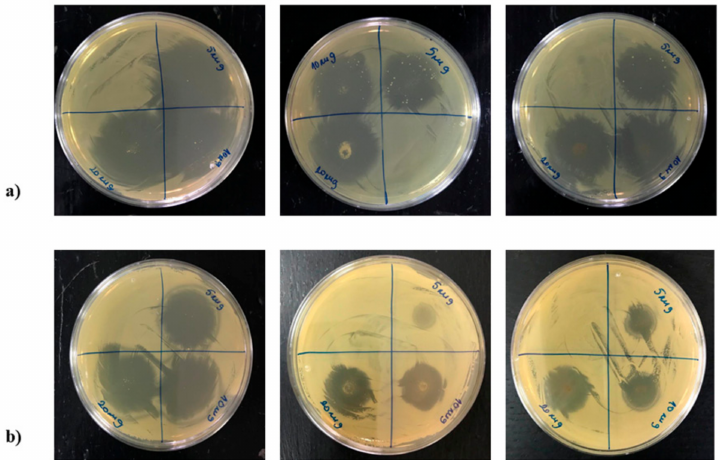
Figure 14. Antibacterial activity of CIP, CLI-CIP and MAG-CLI-CIP towards E. coli ( a ) and S. aureus ( b ). Initial number of bacteria ( t 0 ): E. coli = 1.4 · 10 9 ; S. aureus = 1.2 · 10 9 CFU cm − 3